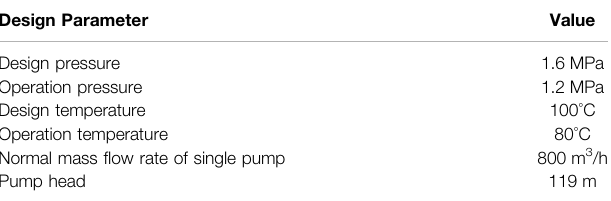
TABLE 2 | Design parameters of test